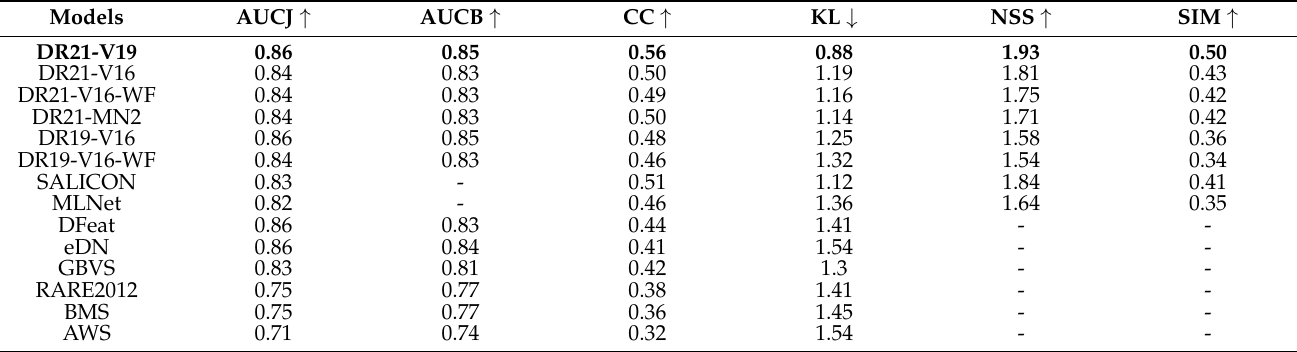
Table 6. MIT1003 dataset. DeepRare2021 (VGG19: DR21-V19, VGG16 without faces: